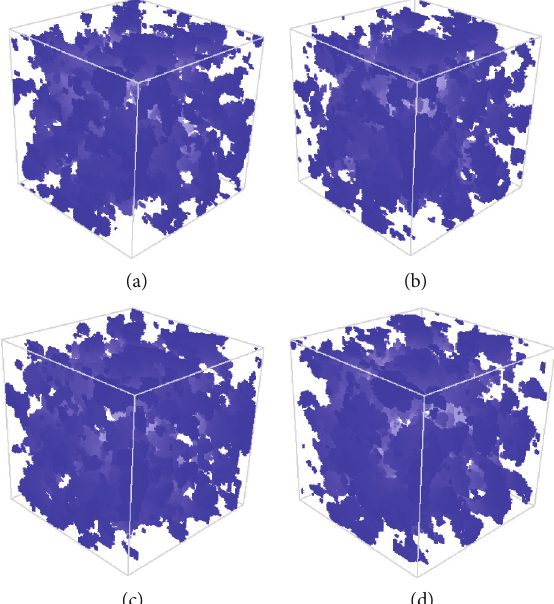
Figure 15: Reconstructed pore spaces of sandstone using (a) DTL; (b) SNESIM; (c) FILTERSIM; (d) DISPAT. Table 1: Porosity of the TIs, the target images, and the reconstructed images using DTL, SNESIM, FILTERSIM, and DISPAT. TI